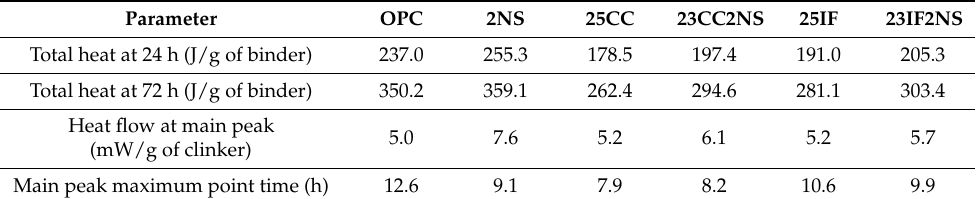
Figure 3. ( a ) Heat of hydration of pastes regularized by binder content until 72 h of hydration. ( b ) Heat flow of pastes regularized by clinker until 24 h of hydration. Table 3. Parameter values obtained from isothermal calorimetry data.